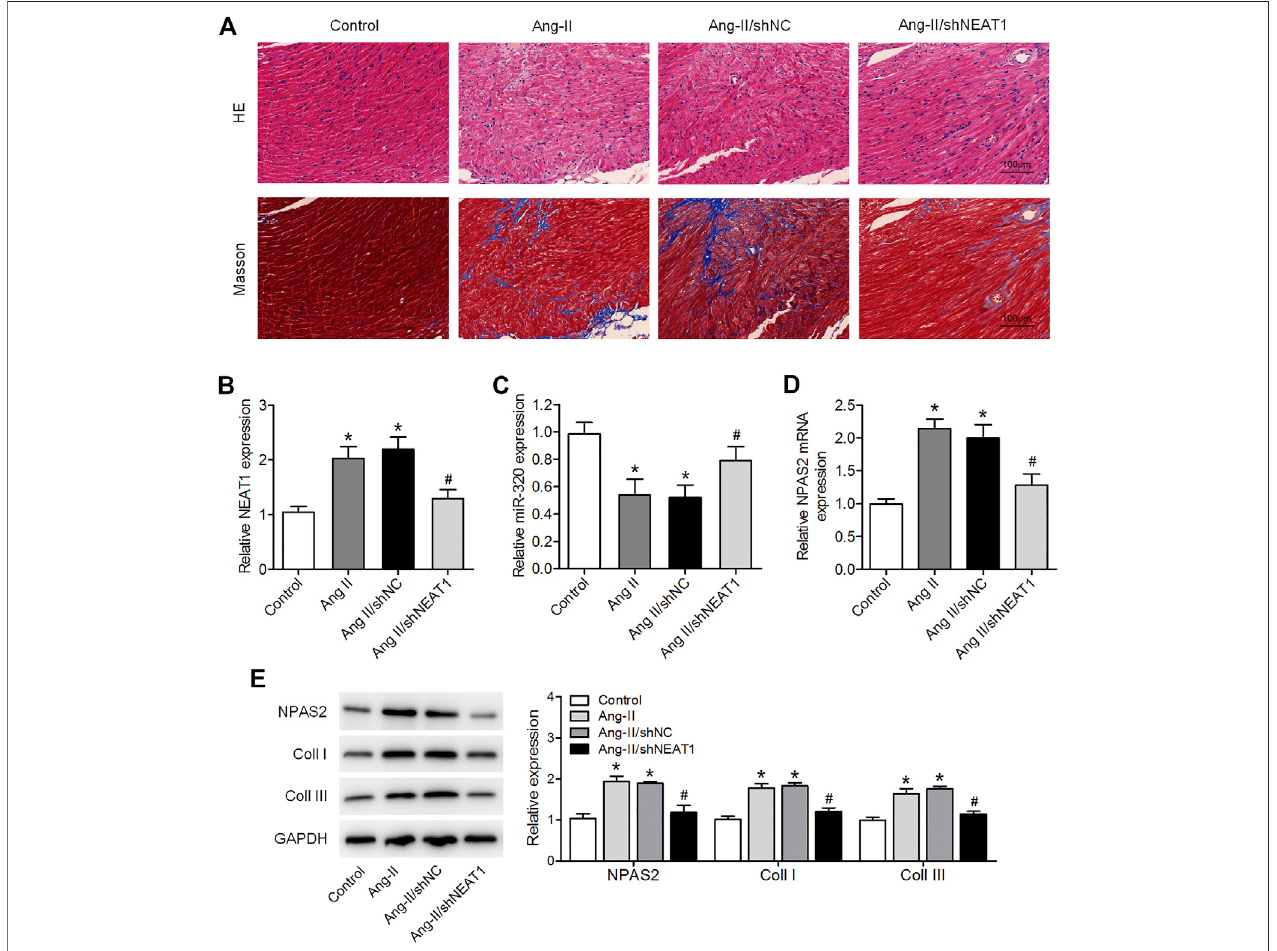
FIGURE 5 | NEAT1 knockdown attenuates the Ang II-induced atrial fi brosis in vivo . (A) HE and Masson ’ s trichrome stainings of murine right atrial tissues. (B,C) NEAT1 and miR-320 expressions in right atrial tissues from each group were detected using qRT – PCR. (D) NPAS2 mRNA expression in right atrial tissues from each group was determined. (E) NPAS2, coll I, and coll III protein expressions in right atrial tissues from each group were detected. * p < 0.05 vs. control group; # p < 0.05 vs. Ang II/shNC group. Data represent mean ± SD from three independent experiments.